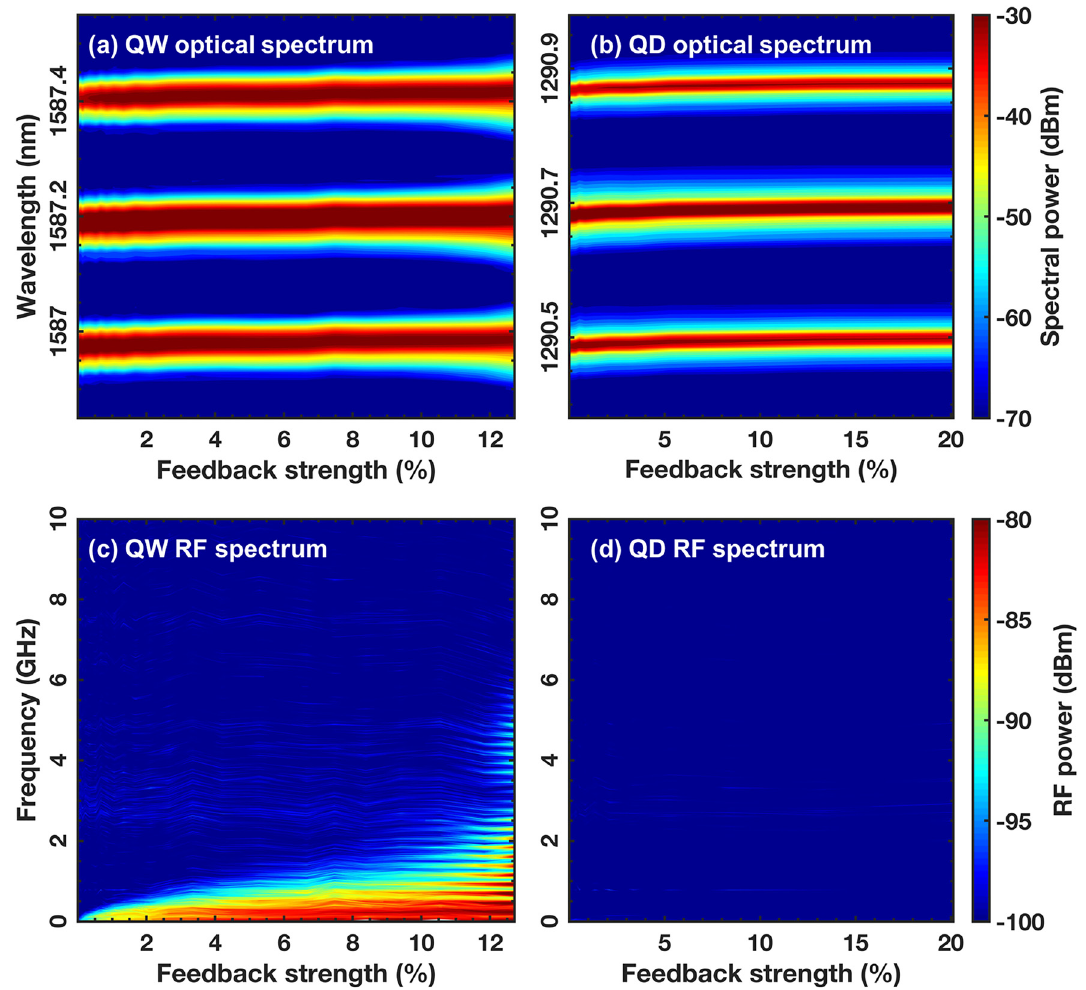
Figure 12: Opticalspectrumof (a) QW laserand (b)QDlaser, andRF spectrumof (c) QWlaser and(d) QDlaser. The feedbackstrengthis varied from 0 to 20% for the QD case (against 13% for the